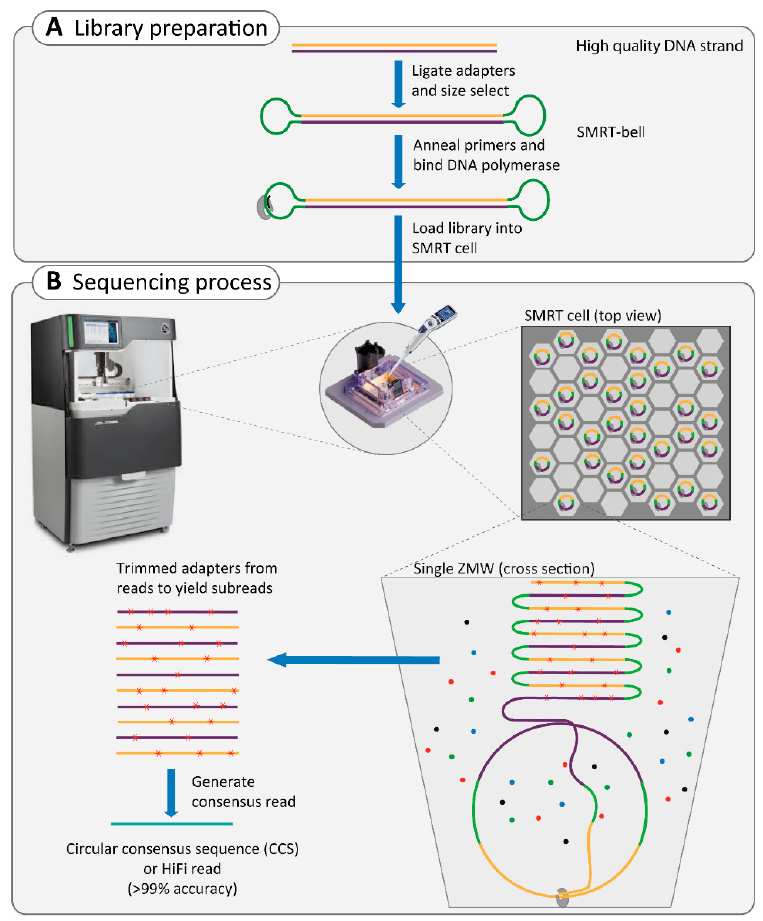
Figure 1. Overview of single-molecule real-time (SMRT) sequencing technology. ( A ) Sequencing starts with library preparation of ultra-long double-stranded DNA. In the next step, adapters, DNA polymerase, and primers bind to the double-stranded DNA, creating the SMRT-bell, which will be loaded later to the SMRT-cell. ( B ) The library is randomly distributed in the SMRT-cell in the sequencer instrument, in the ideal condition one-third of the ZMWs will be loaded by an SMRT-bell. In each ZMW, the DNA polymerase together with an SMRT-bell are bound to the bottom of the ZMW. The SMRT sequencing uses the circular DNA template to generate a continuous long read in each ZMW chamber. Afterwards, the adapters are trimmed from this long read and overlapping reads can be combined to one consensus sequence of high quality called HiFi read.